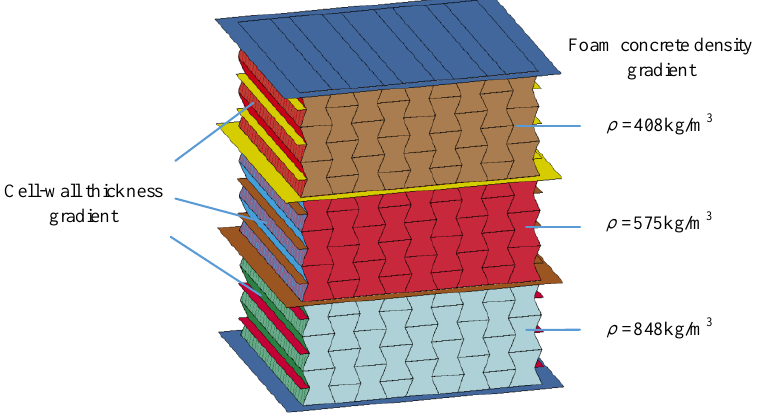
Figure 10. The numerical model of the composite with foam concrete density gradient: a general